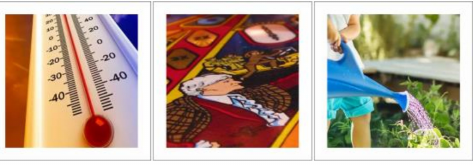
Figure 24. NFT markers.